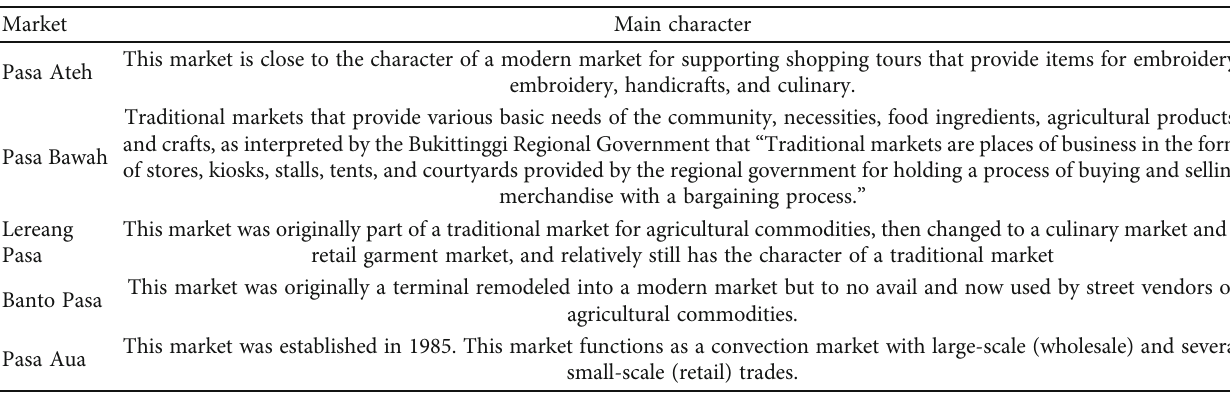
Figure 1: Conceptual framework. Table 1: Characters of Five Markets in Bukittinggi City.